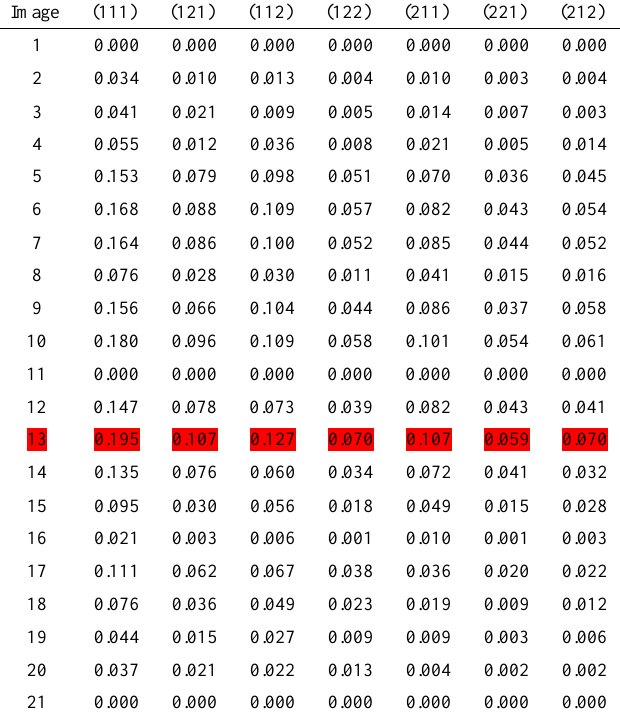
Table 2. Calculation of Comprehensive Correlation Coefficient Results for Different Combination Factors (α,β,θ ) Table 2 shows the results of the CCCM method in the case of selecting different combination factors. The different combination factors obtain the maximum value in the 2015-12- 02 image, i.e., image No. 13 (red highlighted), which indicates that the method selects the 2015-12-02 image as the master image. It can be seen from Table 2 that the correlation coefficient obtained by selecting different combination factors shows a certain similarity, which indicates that different combination factors have little impact on the master image selection. Thus, (α, β, θ) = (1, 1, 1) can be set to select the correlation coefficient of the master image for the master image selection. According to the calculation results in Tables 1 and 2, the corresponding curve is drawn as in Fig. 2. (The X-axis represents the image sequence numbers arranged in chronological order. The Y-axis represents the results of three methods, The baseline optimization result is expanded 10,000 times, and the CCCM result (1,1,1) is expanded by 20,000 times.) The 10th and 13th scene images were used as the master images separately, and for the statistics of the time-space baseline of the other auxiliary images and the maximum, mean, standard deviation, optimized value, and comprehensive correlation coefficient of the baseline of the Doppler centroid Table 1. Comparison of Experimental Results frequency, the results are shown in Table